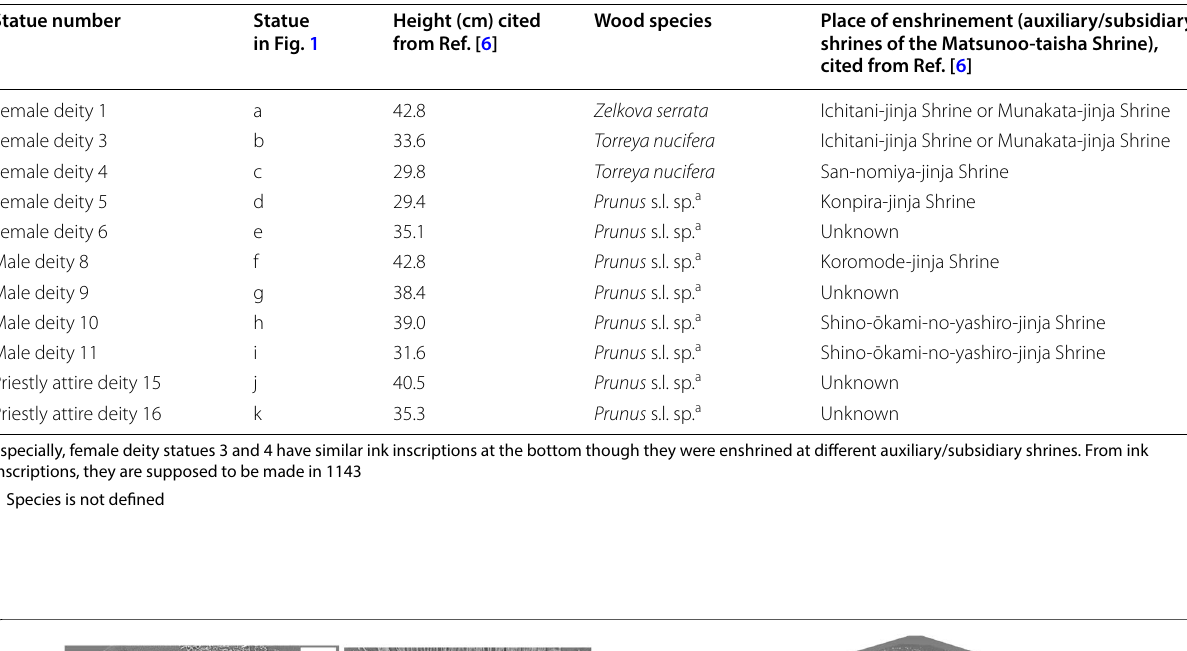
Table 1 Details of deity statues and identification results